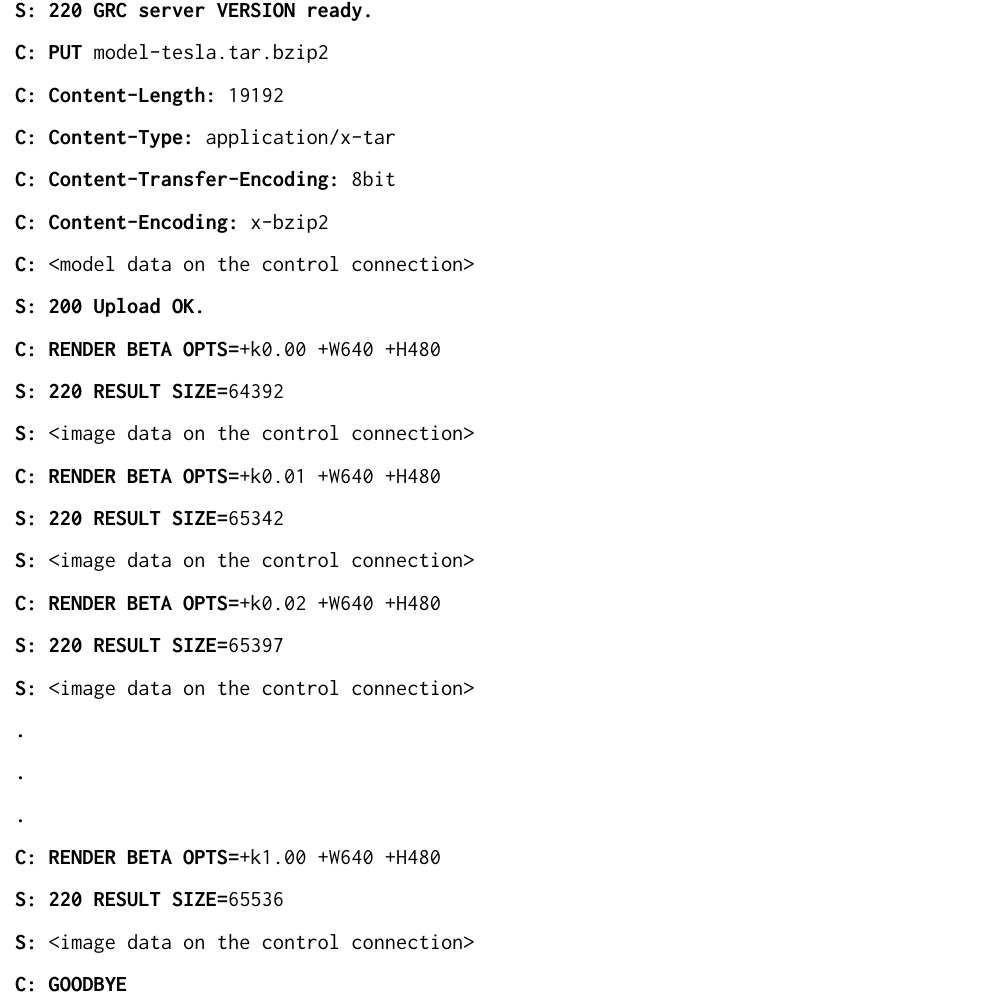
Table 1 shows the GRP protocol diagram of how it works on clock animation images for moments t = 0.00, 0.01, 0.02 . . . 1.00, or trace of one typical session. Table 1. GRP protocol diagram (trace of one typical